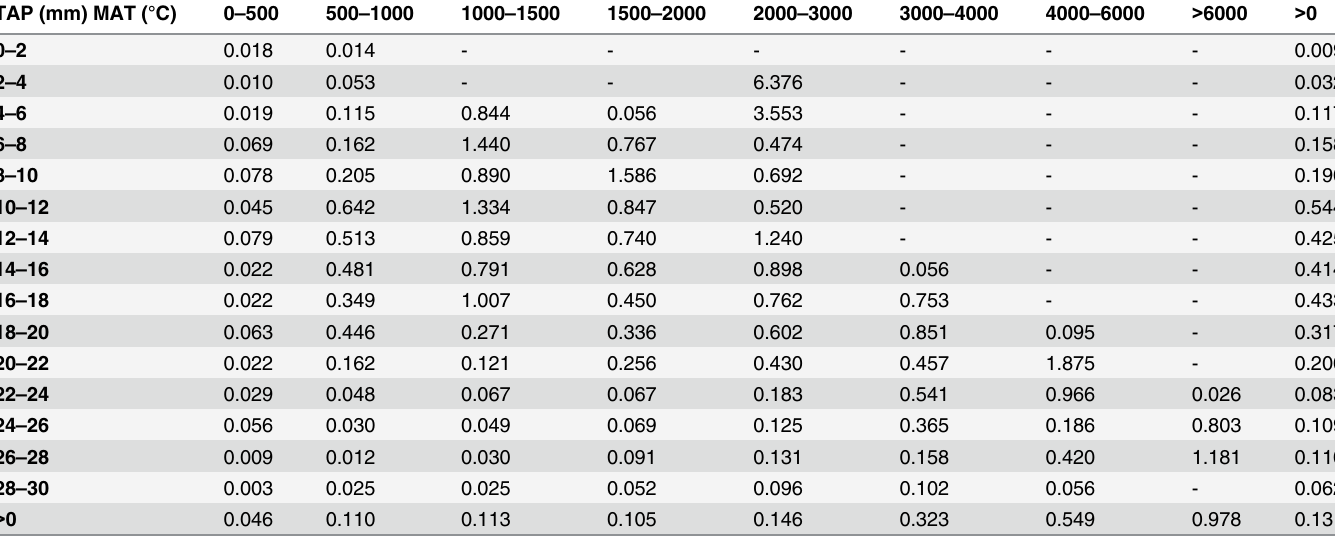
Table 4. The density of collection records (No. col / km2) available for areas under different climatic conditions as defined by current Total Annual Precipitation (TAP) and Mean Annual Temperature (MAT). TAP (mm) MAT (°C)